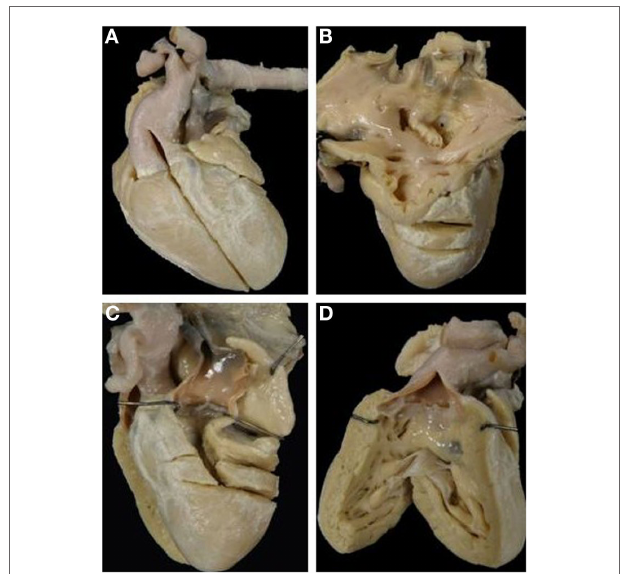
FigUre 13 | Discordant Va connection with absent left aV connection in situs solitus (mitral atresia) . (a) External view of the heart with right anterior position of the aorta. (B) View from the left atrium: the left AV valve is absent. (c) The pulmonary artery takes origin from a hypoplastic left ventricle. (D) The aorta originates from the right sided morphological right ventricle with a subaortic infundibulum.